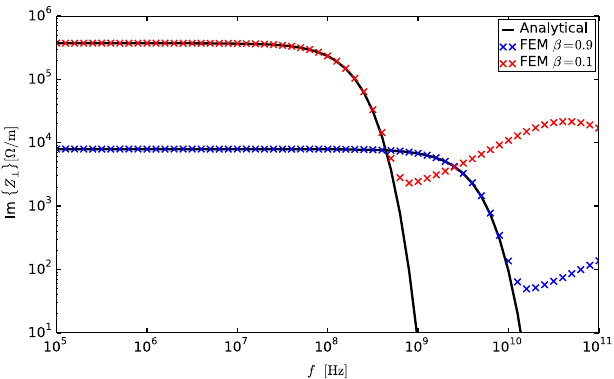
FIG. 6. Transverse space charge impedance (only indirect). The dimensions are the same as in Fig. 4.